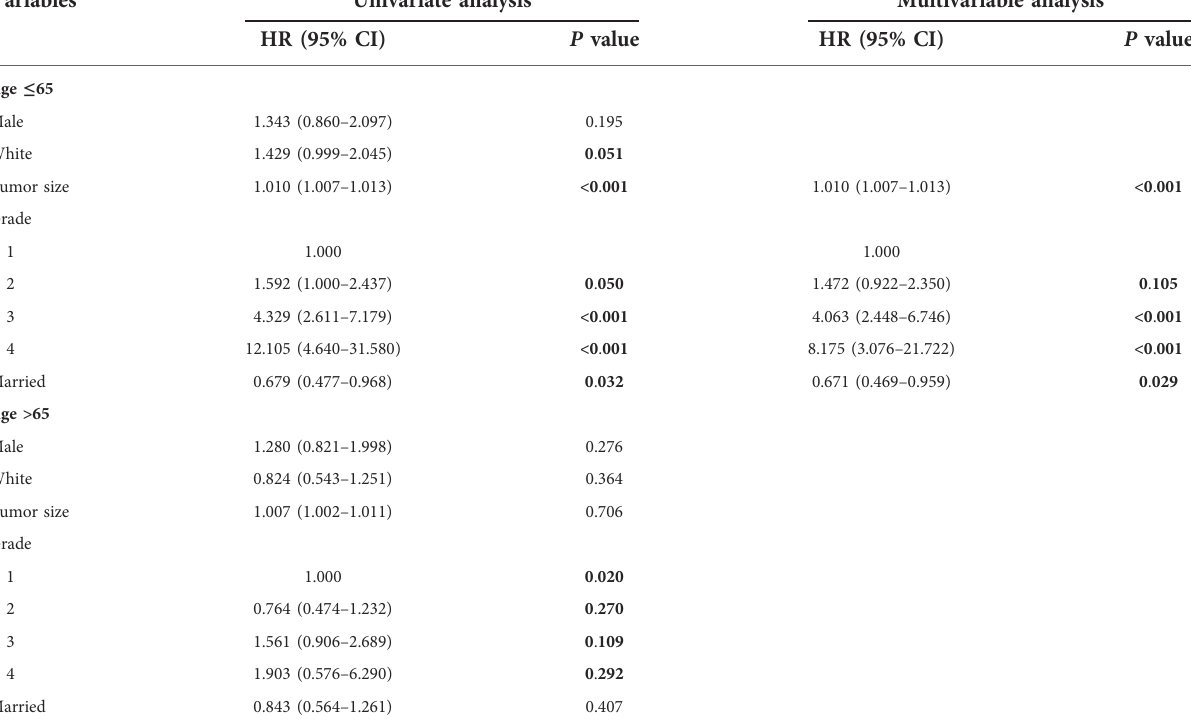
TABLE 4 Univariate and multivariable analyses of the two subgroups with different ages in SEER database cohort. Variables